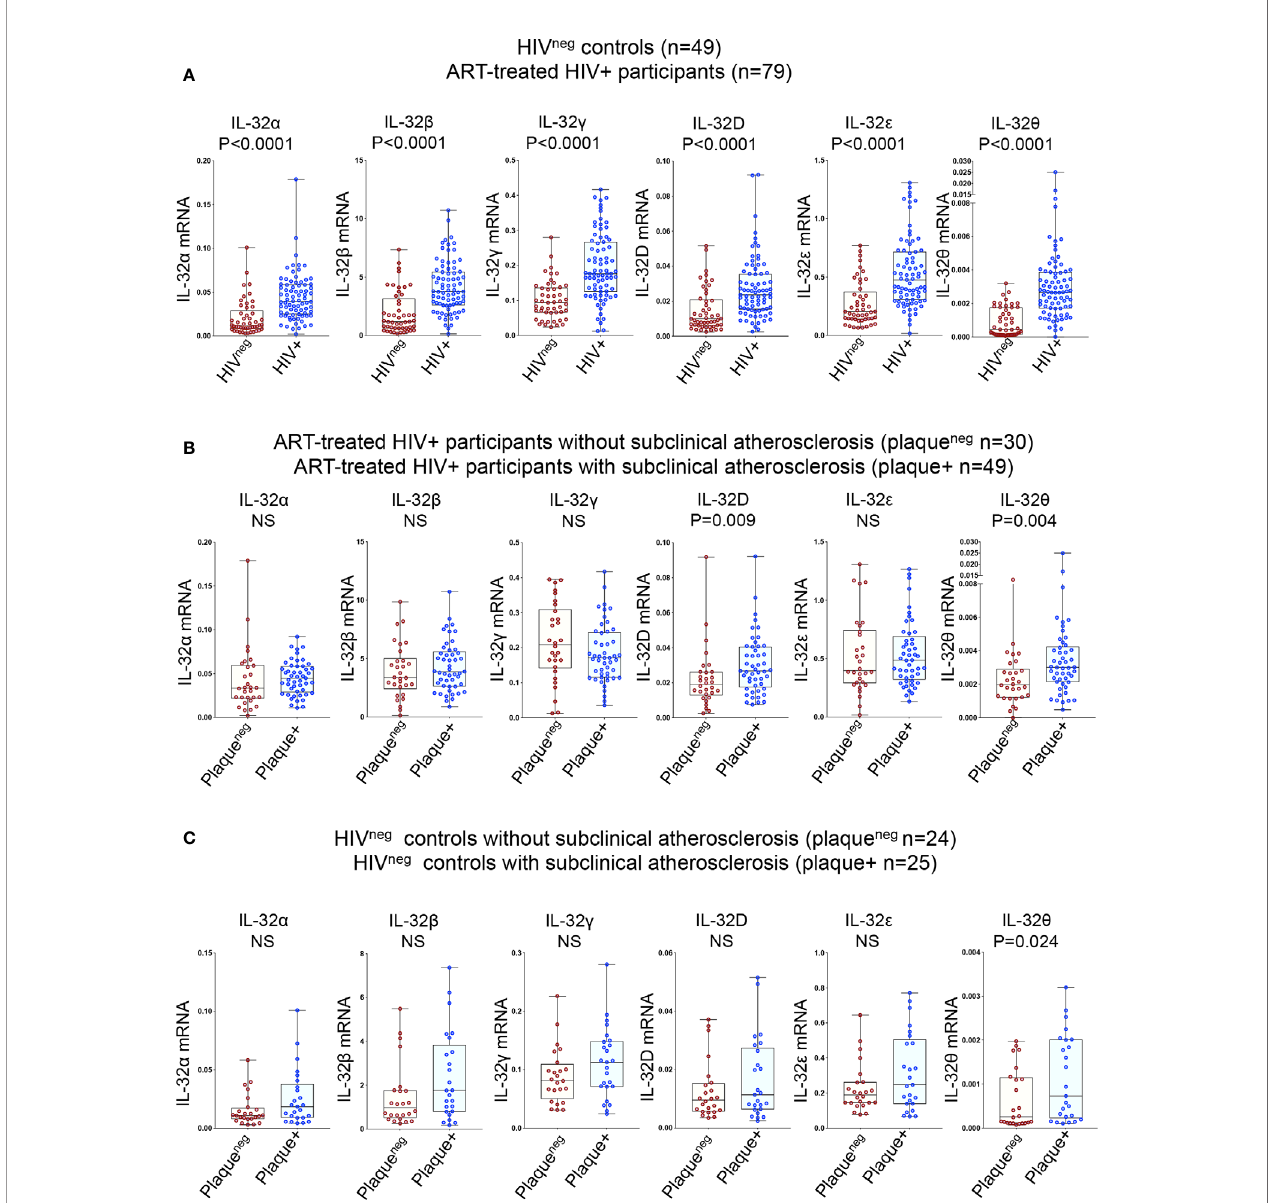
FIGURE 1 | Relative expression of IL-32 isoforms in HIV+ and HIV neg individuals (with or without subclinical atherosclerosis) shown in Box-whiskers plot (min-max). (A) RT-qPCR data for IL-32 isoforms ( a , b , g , D, ϵ and q ) ampli fi ed from total PBMCs of HIV neg (n=49) compared to HIV+ individuals (n=79). (B) HIV+ individuals without or with subclinical atherosclerosis (n=30 plaque neg and n=49 plaque+, respectively). (C) HIV neg individuals without or with subclinical atherosclerosis (n=24 plaque neg and n=25 plaque+, respectively). IL-32 RNA levels were normalized to the housekeeping gene b -glucuronidase. P values are calculated with the non- parametric Mann-Whitney test. NS, non-signi fi